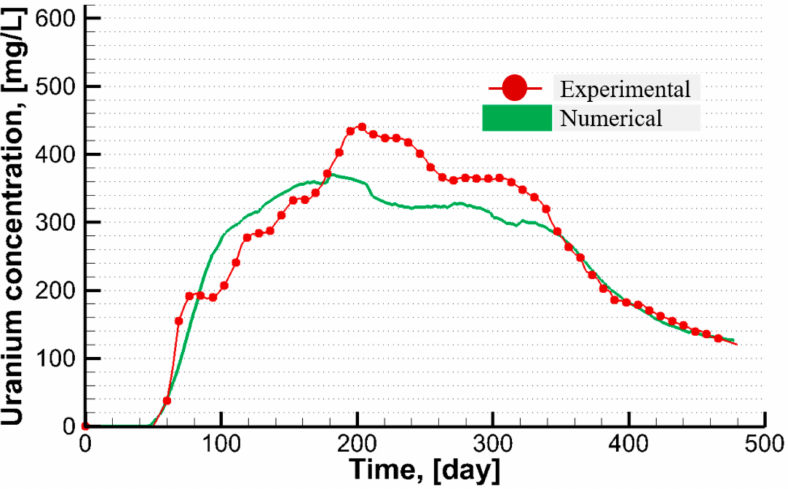
Figure 14. Simulated production curve vs. time compared with the experimental data. The total uranium concentration in flowing solutions at production wells is plotted on the vertical axis.